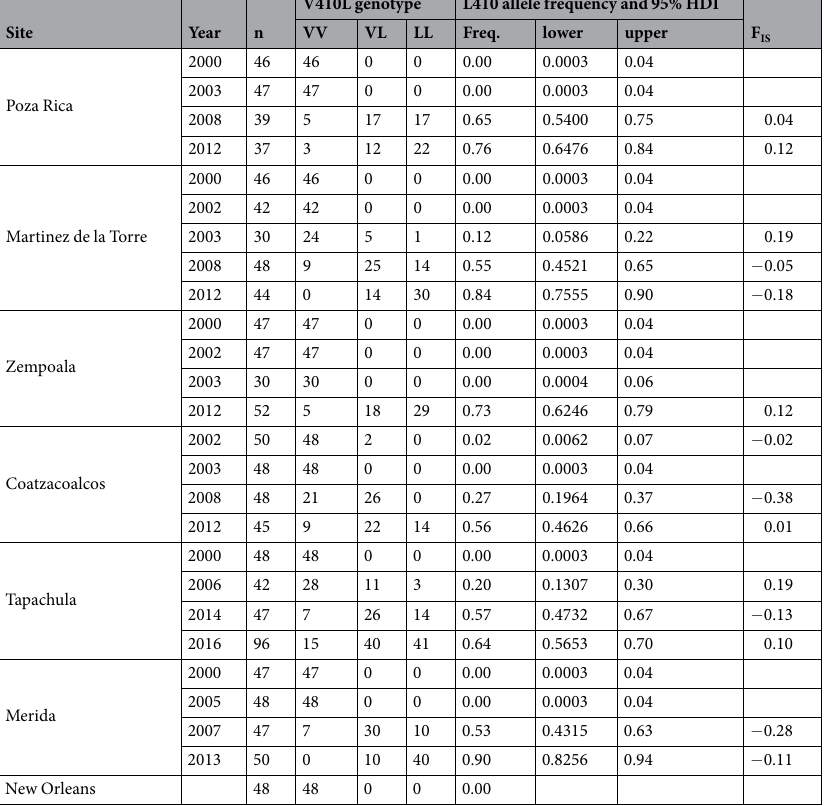
Table 1. V410L genotypes and allele frequencies in 25 collections from Mexico. The site, year, sample size, genotype frequency, L410 allele frequency, 95% high density intervals (HDI) and inbreeding coefficients (F IS ). L = resistant allele, V = susceptible allele.